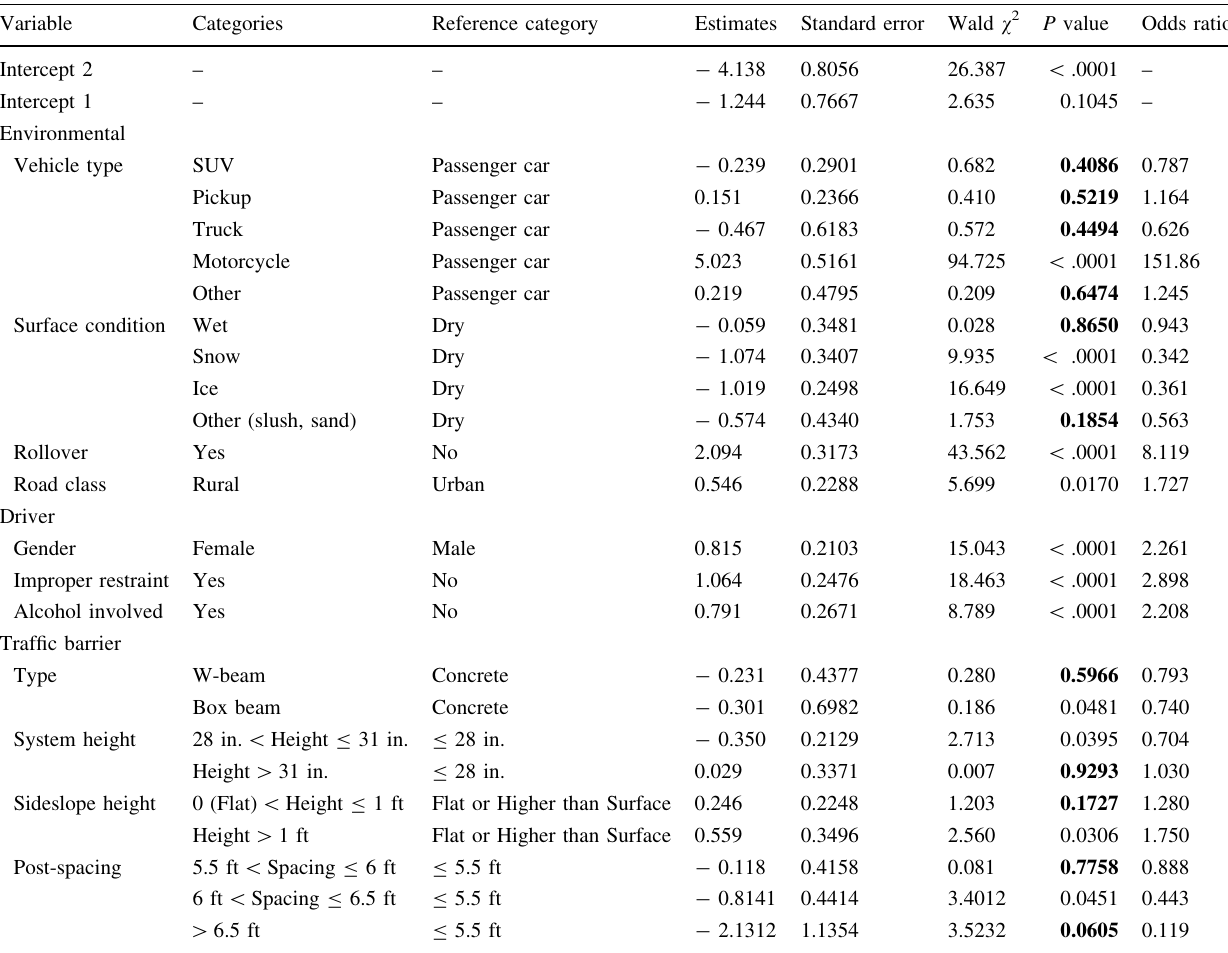
Fig. 3 A crosscut view of roadways with a side traffic barrier Table 2 Ordered logistic regression for severity of crashes involving traffic